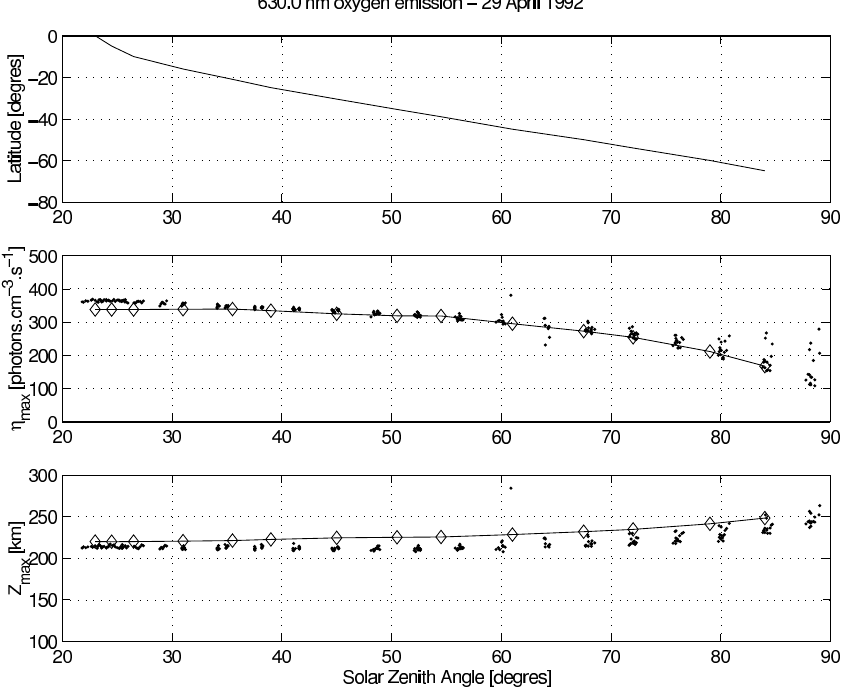
Fig. 7. 630.0nm oxygen line – 29 April 1992 – f 10 . 7 = 128 . 5 ,A p = 7. Dots correspond to WINDII measurements and line/diamonds correspond to TRANSCAR